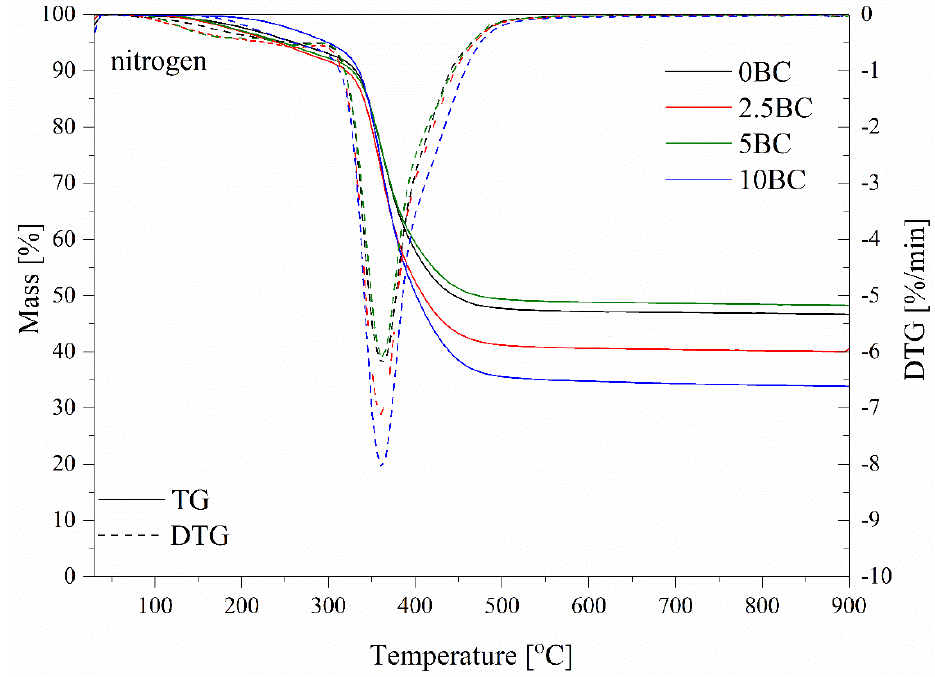
Figure 8. The diagrams of TG and DTG for analyzed materials obtained in a nitrogen atmosphere.